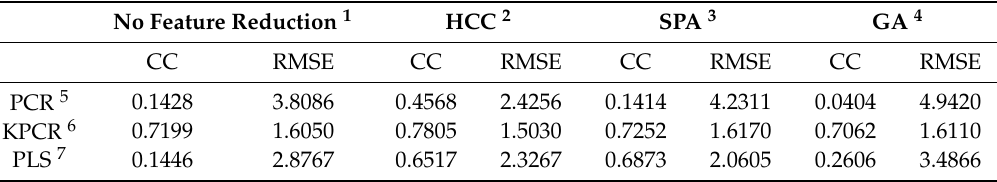
Table 1. Comparison of hyperspectral data and root length prediction for corn seeds.